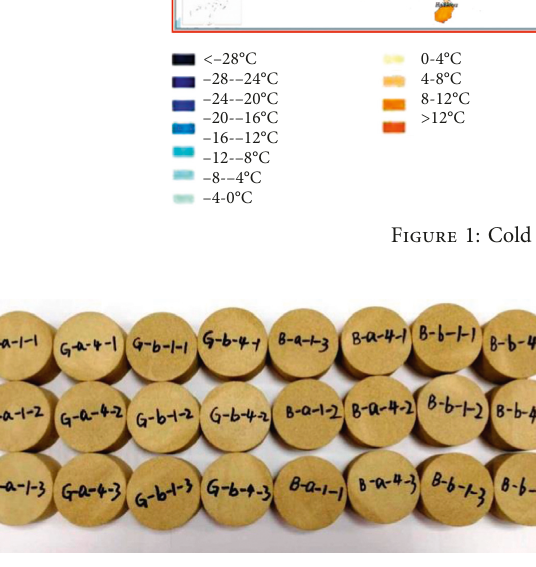
Figure 2: Yellow sandstone samples in this study.